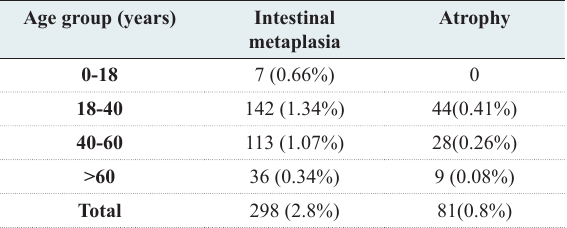
Table 3: Distribution of Atrophy and Intestinal metaplasia according to age